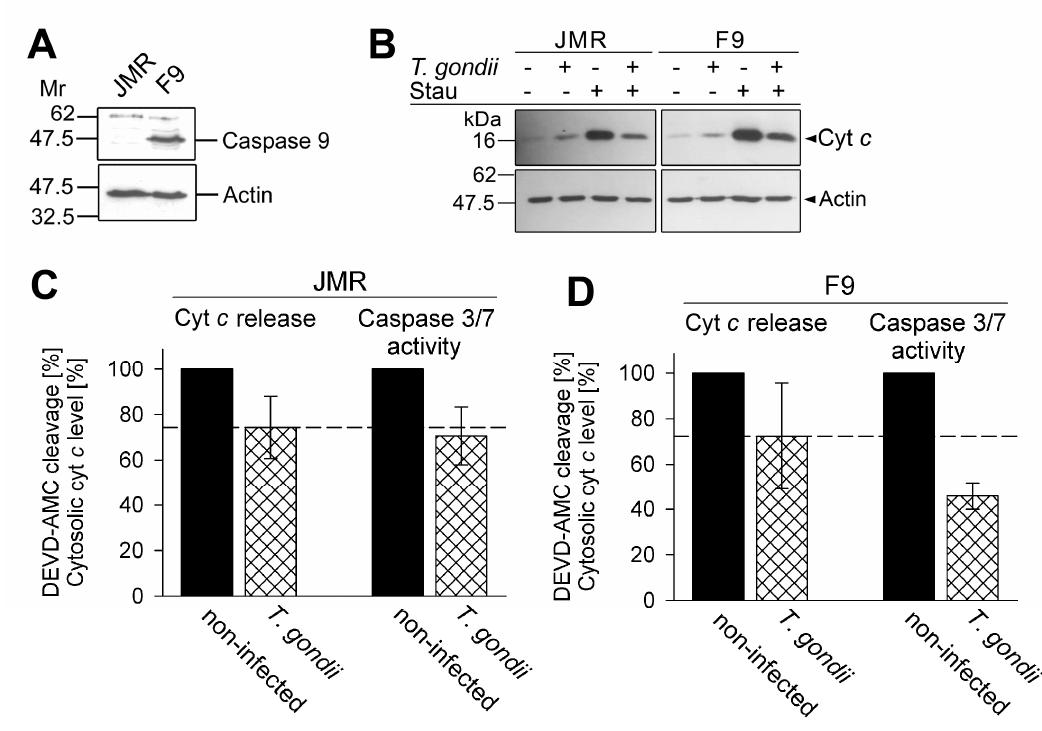
FIGURE 3: Total inhibition of the intrinsic apoptotic pathway by T. gondii considerably relies on a mechanism that operates down-stream of mitochondrial cytochrome c release and which relies on caspase 9. (A) Total cell lysates were prepared from caspase 9-deficient Jurkat cells (clone JMR) and a reconstituted mutant thereof (F9) and were separated by SDS-PAGE. After protein transfer, nitrocellulose membranes were probed with antibodies recognizing caspase 9 and actin. Immune complexes were visualized using peroxidase-conjugated secondary antibodies and enhanced chemiluminescence. (B) JMR and F9 cells were infected with T. gondii for 24 hours (MOI 20:1) or were left non- infected and were then treated or not with staurosporine to trigger the cell-intrinsic PCD pathway. After 90 minutes, cytosolic proteins were isolated by digitonin lysis (digitonin-soluble extract). Proteins were resolved by SDS-PAGE and after transfer to nitrocellulose, were probed with antibodies recognizing cytochrome c (cyt c ) or actin. Bound antibodies were visualized using peroxidase-conjugated secondary antibod- ies and enhanced chemiluminescence. Band intensities of cytosolic cytochrome c after treatment of cells with staurosporine were deter- mined by densitometric analysis and were normalized to actin band intensities. (C, D) Cells were infected with T. gondii and/or treated with staurosporine as described above (B). After cell lysis, cleavage of the caspase 3/7 substrate DEVD-AMC was measured fluorimetrically. Data represent the increase of cleaved substrate over time. For comparison, the levels of cytosolic cytochrome c as determined by densitometric analysis (B) are displayed. Results are expressed as mean percentages ± S.E.M. of at least three independent experiments; the caspase 3/7 activities and the levels of cytosolic cytochrome c in non-infected cells have been set to